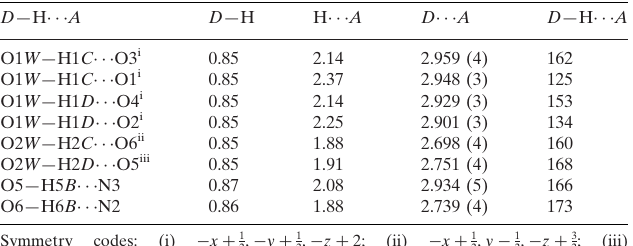
Hydrogen-bond geometry (A˚ , (cid:4)